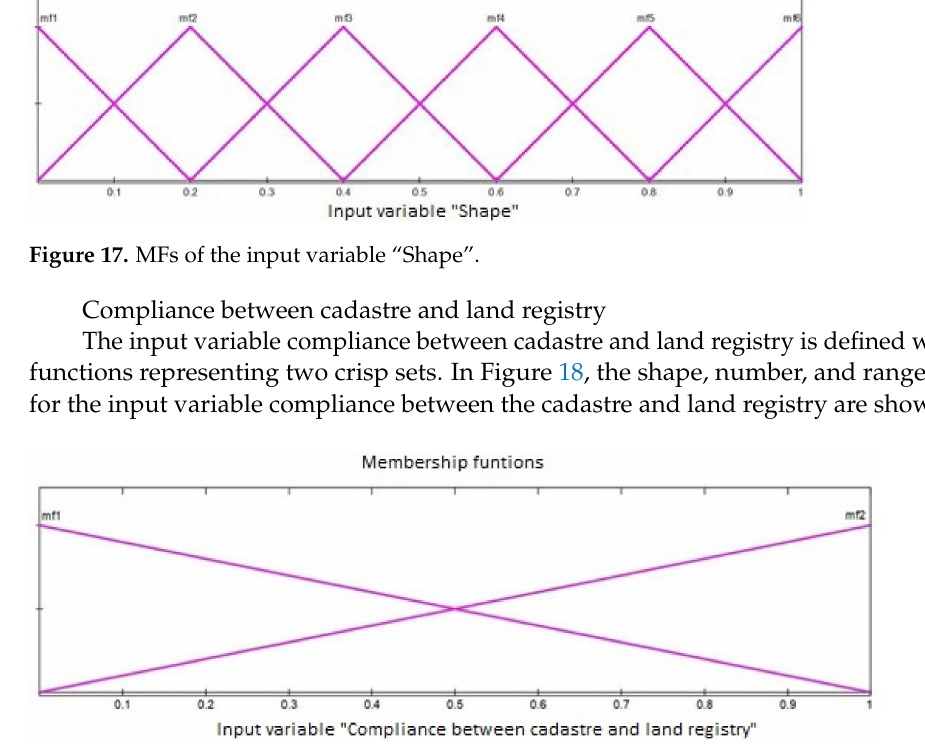
Figure 18. MFs of the input variable “Compliance between cadastre and land registry”.